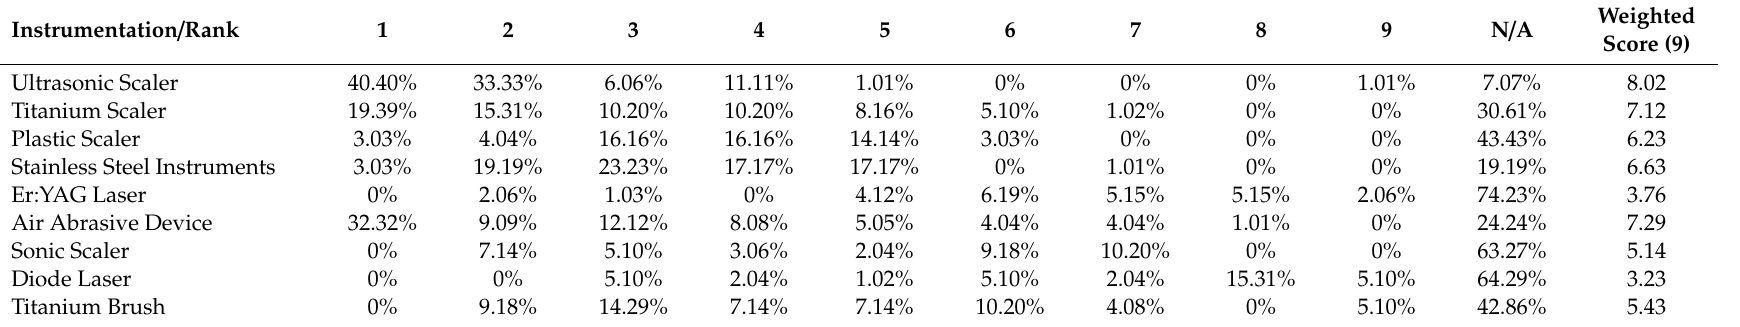
Table 6. Debridement instrumentation / devices ranking: weighted score out of 9 (higher = more commonly chosen).